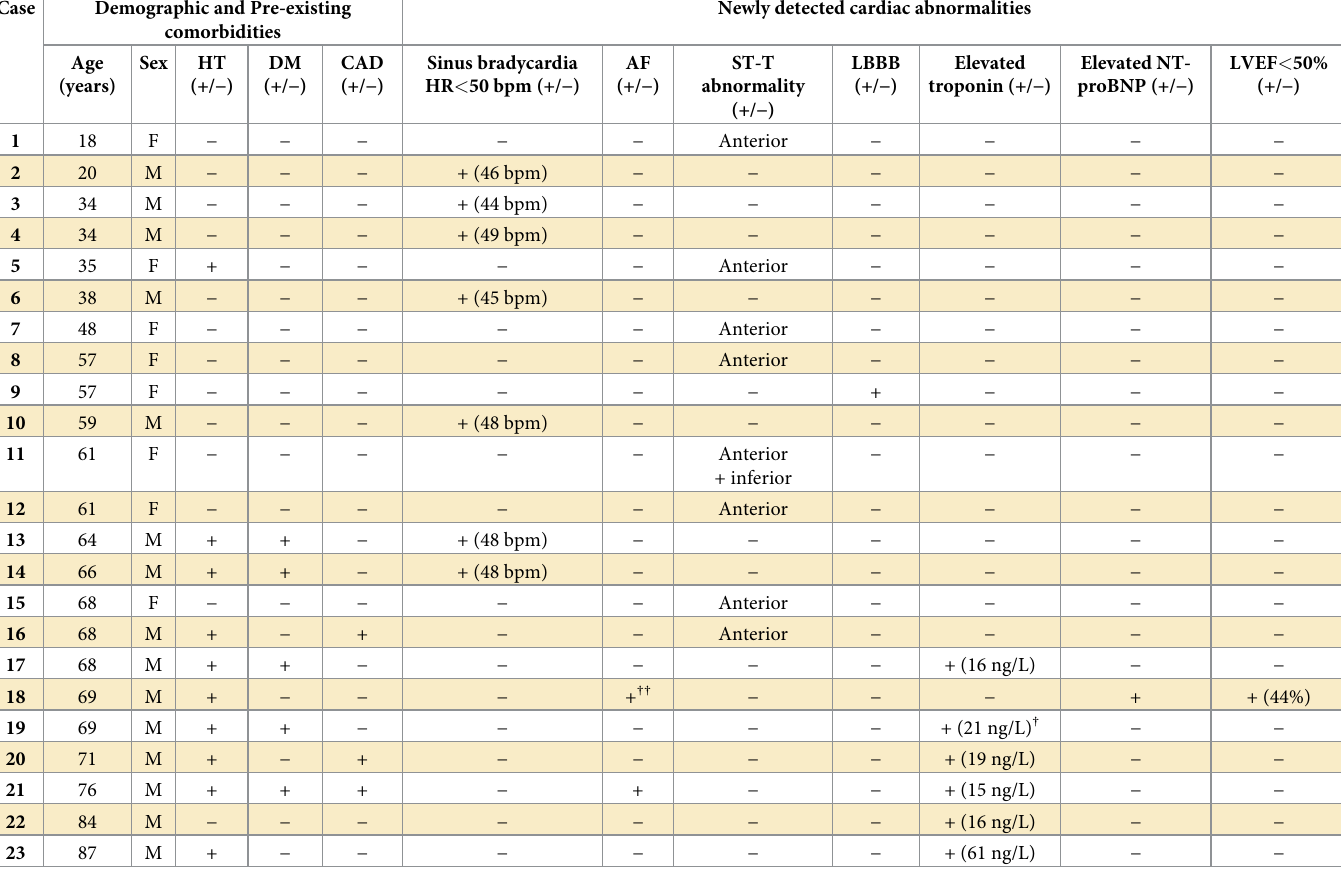
Table 3. Newly detected cardiac